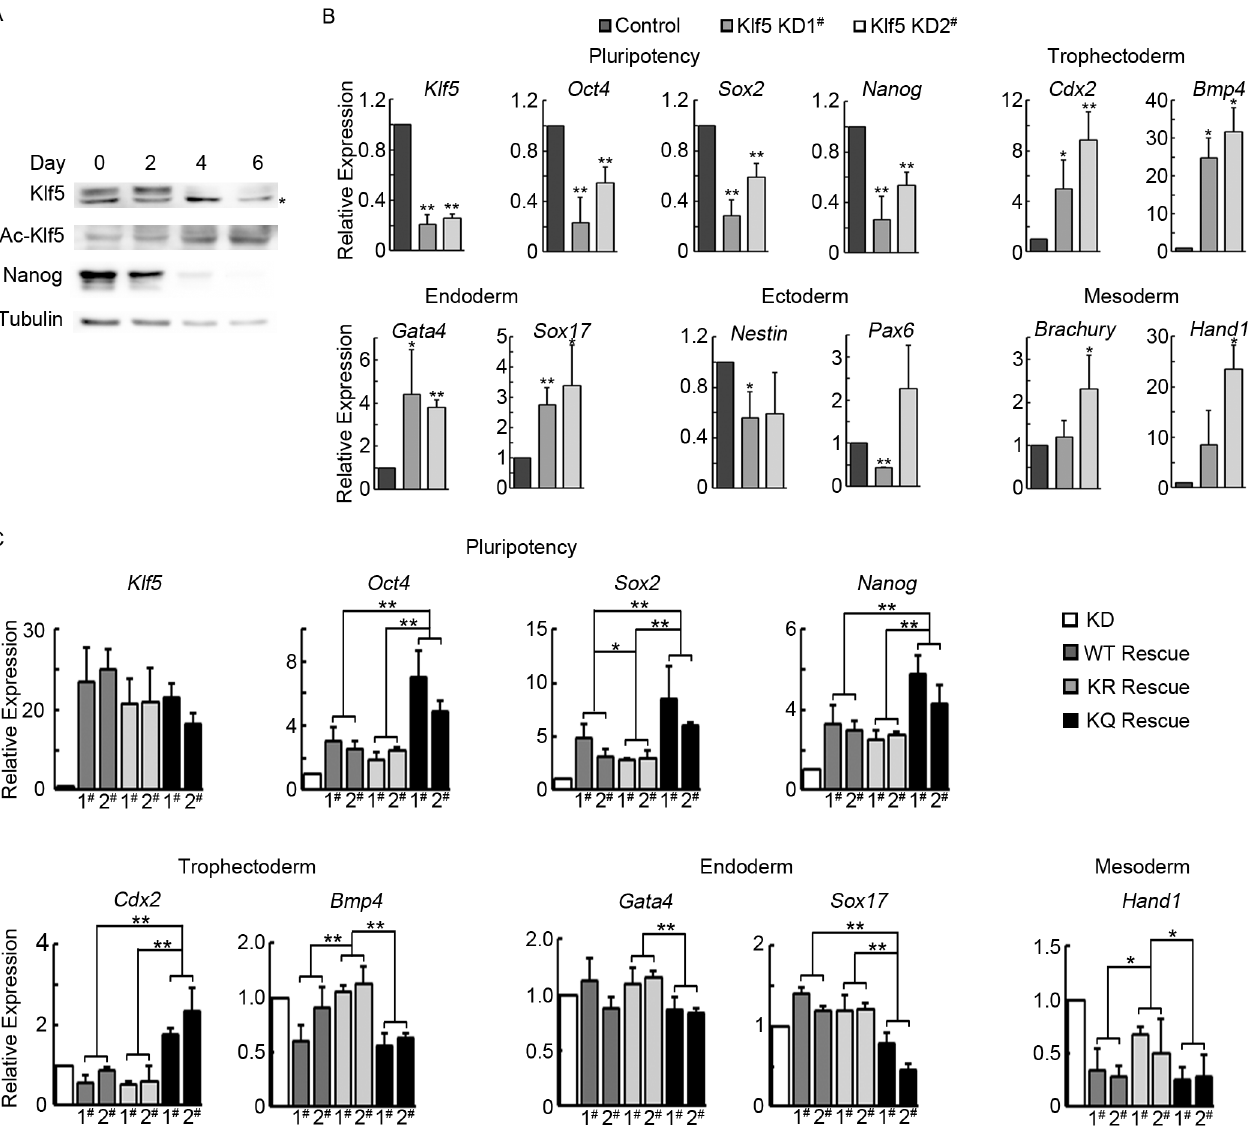
Fig 4. Functions of acetylated Klf5 in mouse ESC differentiation. (A) Expression of total, Ac-, and unAc-Klf5 during ESC differentiation. The nonspecific band in the anti-Klf5 blot is marked by an asterisk. V6.5 ESCs were cultured without LIF and feeder cells. Cells were harvested on day 0, 2, 4, and 6, and subjected to Western blot assay. (B) Klf5 knockdown affects the expression of pluripotency genes and differentiation genes in day 4 EBs. Day 4 EBs from shGFP control ESCs and two independent stable Klf5 knockdown ESC clones were harvested for quantitative RT-PCR analysis. Averages and standard deviations from three independent experiments were plotted. (C) Rescue effect of WT, KR, and KQ Klf5 in Klf5 knockdown ESCs. shKlf5 targeting sequences in WT, KR, and KQ Klf5 were mutated to render them resistant to shKlf5 knockdown. Stable ESC lines overexpressing shKlf5-immune WT, KR, and KQ Klf5 were established in the Klf5 knockdown ESCs. Day 4 EBs from these ESCs were harvested for quantitative RT-PCR analysis. Averages and standard deviations from three independent experiments were plotted. P values were calculated by reusable two-factor analysis of